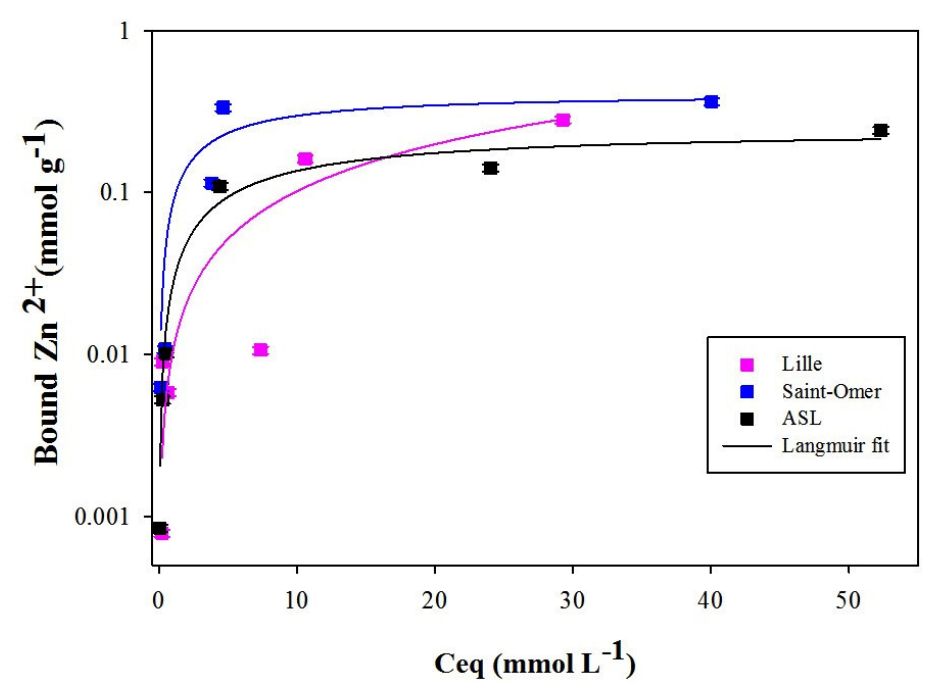
Figure 4. Zn binding onto the three raw